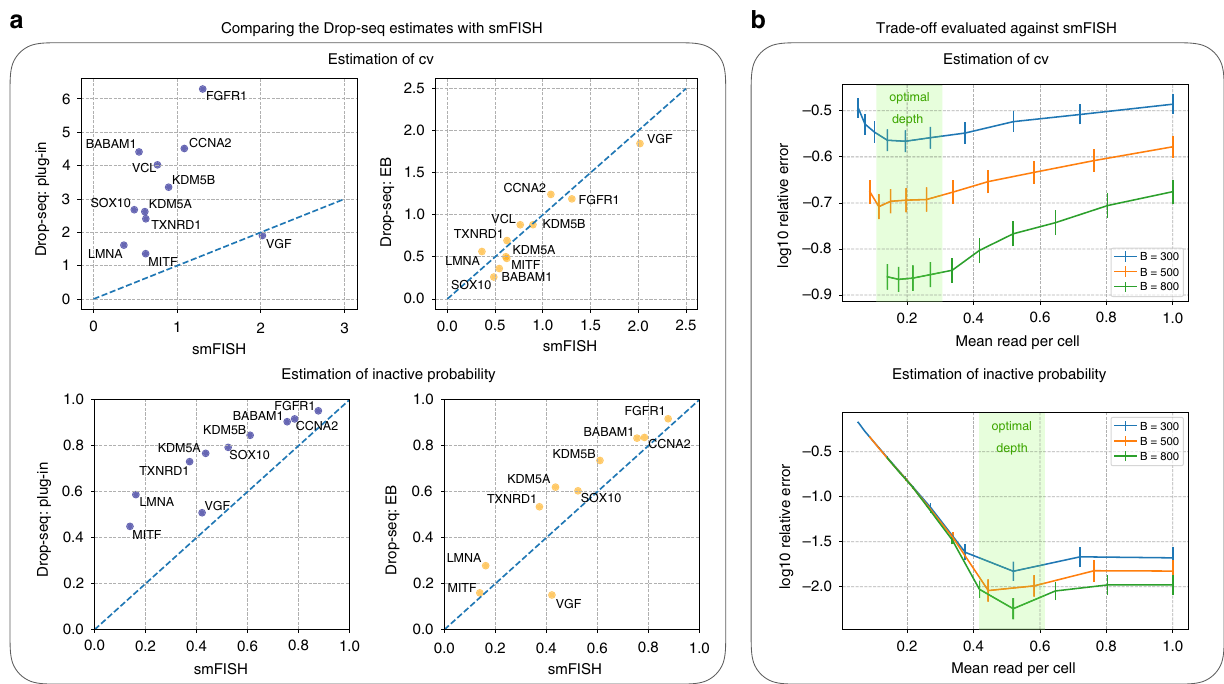
) from the Drop-seq data are compared with reads